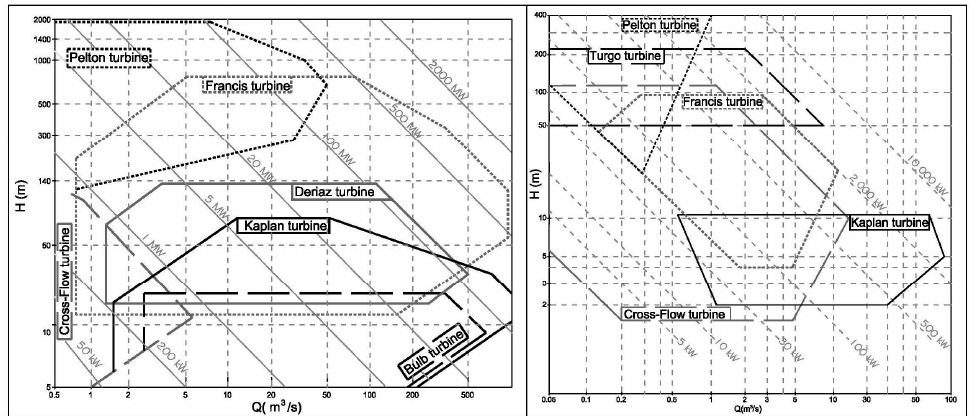
Figure 5. Selection of turbine depending on head and flow in: large ( left ); and small ( right ) hydropower [16,31].